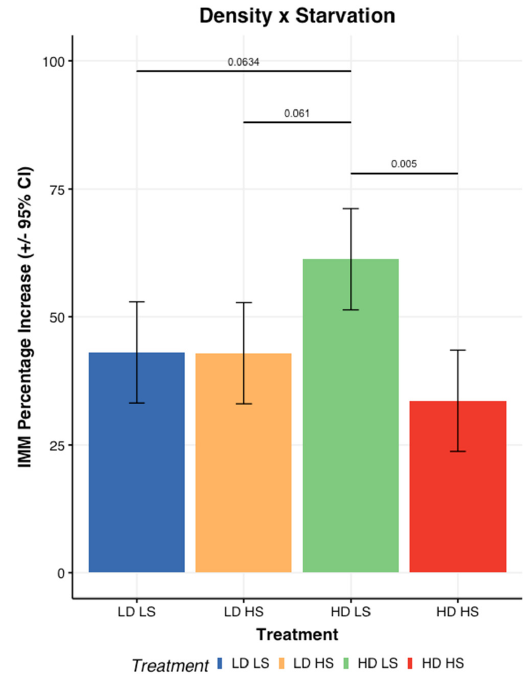
Figure 2. Impact of starvation and density on Individual Mean Mass increase. The IMM relative gain is expressed as a percentage. In this figure, LD and HD stand for low and high larval density, while LS and HS stand for no-starvation and starvation, respectively.